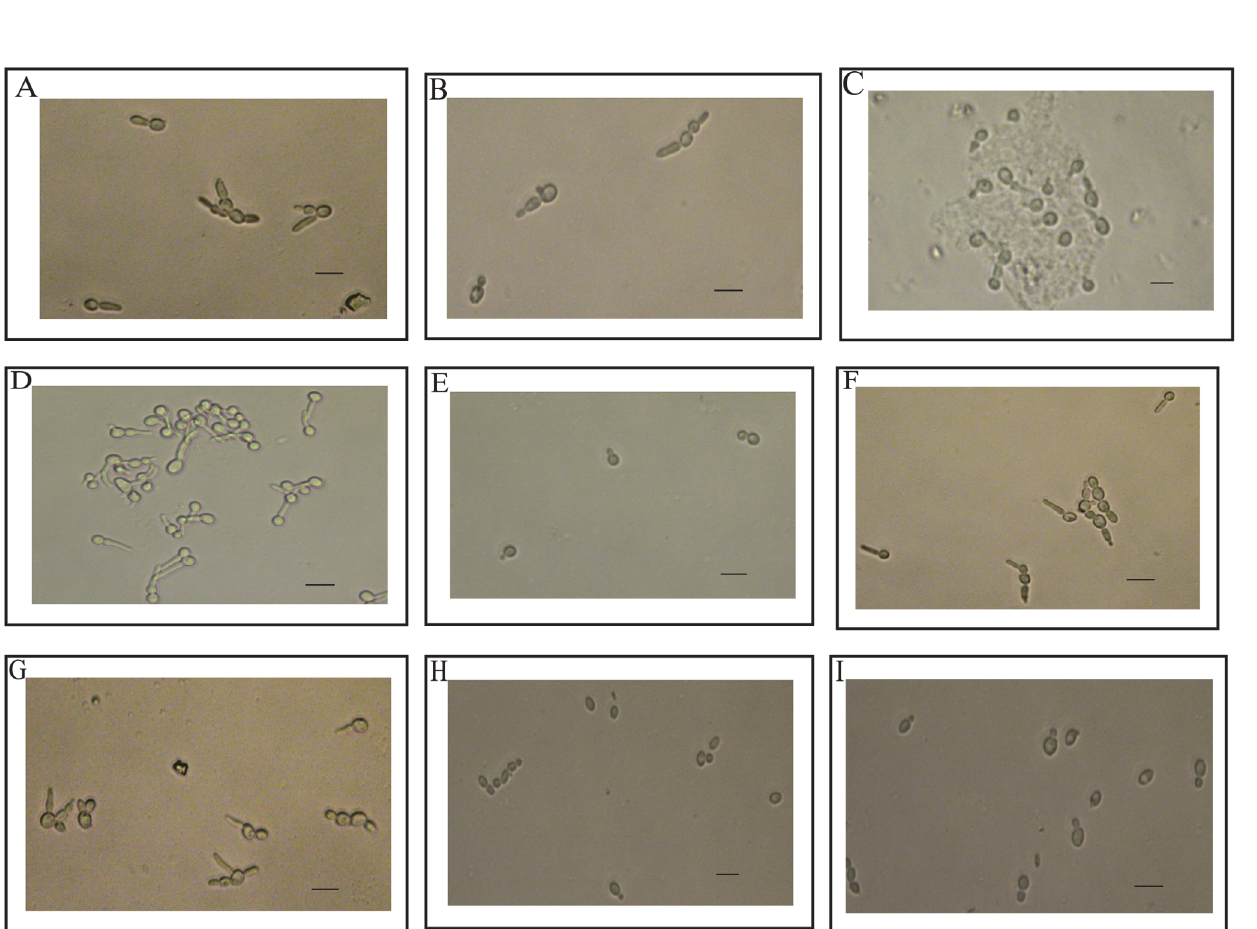
Fig 1. Yeast cells exposed to various solutions. A. C . albicans in water plus 10% FBS for 30 min. B. C . albicans in YPD plus 10% FBS for 30 min. C. C . albicans in 100% FBS for 30 min. D. C . albicans in water plus 10% FBS for 60 min. E. C . albicans in water for 60 min. F. C . dubliniensis in water plus 10% FBS for 60 min. G. C . tropicalis in water plus 10% FBS for 60 min. H. C . glabrata in water plus 10% FBS for 60 min. I. C . krusei in water plus 10% FBS for 60 min. All assays were done at 37°C. Pictures were taken at 40X magnification. The bars represent 10 μ